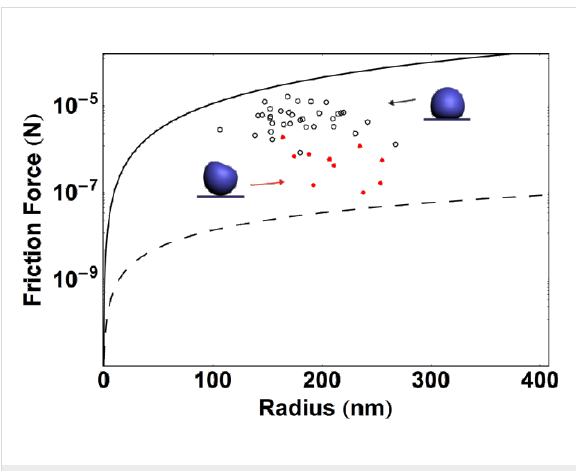
Figure 9: The static friction force of Ag NPs on a Si wafer as a func- tion of the radius of the NPs. The static friction force values experimen- tally measured by QTF (dots) and calculated from the diameters of visible traces left after the displacement of the particles (circles). The theoretical curves of friction as functions of the radius of the NPs according to the DMT-M model (dashed curve) and frozen droplet model (solid